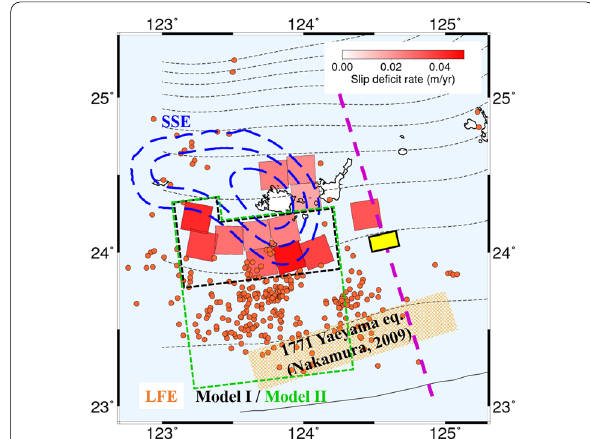
Fig. 4 Summary of spatial distributions of various fault slips in the southern Ryukyu subduction zone. The red-colored squares indicate the SDR estimated in this study (Fig. 3c). The blue contours are the average slip rate in the SSE region, which were calculated from the cumulative slip from July 2010 to February 2013 (Kano et al. 2018b) with a contour interval of 40 mm/year. The orange dots represent the epicenters of LFEs (Arai et al. 2016; Nakamura 2017). Note that only the relocated LFEs in Nakamura (2017) using the S-P time delays, as well as the cross-correlation of the envelope waveforms, are plotted. The orange- and yellow-colored squares are the source models of the 1771 Yaeyama earthquake estimated by Nakamura (2009) and Imamura et al. (2001), respectively. The purple line indicates the location of the seismic survey (Arai et al.